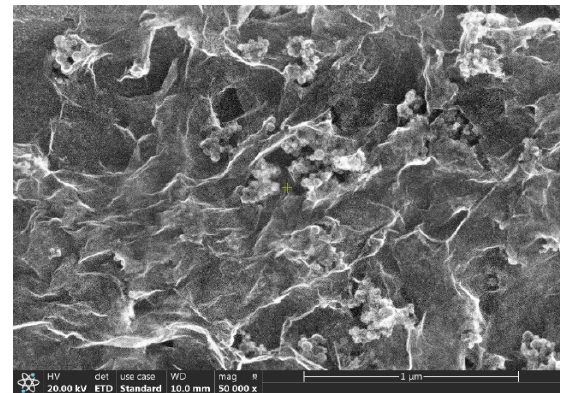
Figure 3. SEM image of the deposit containing Si NPs and GO nanofluid after 20× dilution with ethanol and drying.